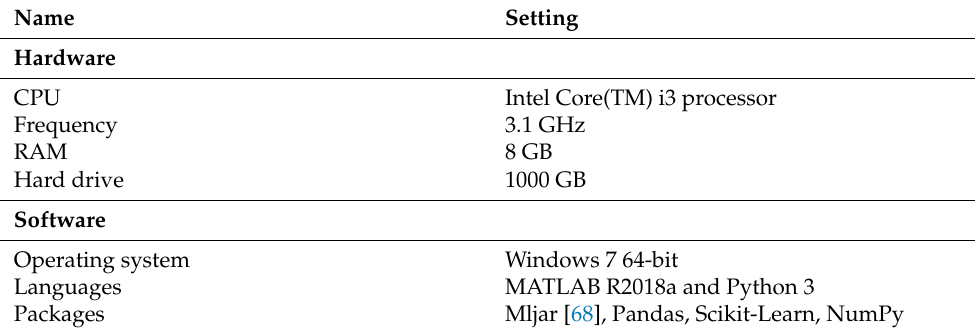
Table 2. The detailed settings of the utilized